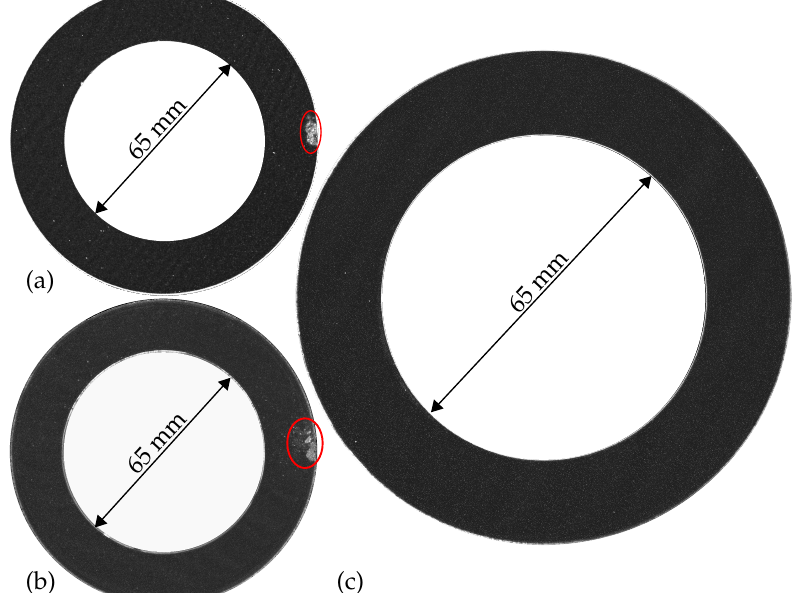
Figure 9. SAM measurments of semi finished parts: ( a ) first batch after welding and machining, ( b ) first batch after welding, machining and 200 h in the test rig and ( c ) second batch after fatigue life test with no